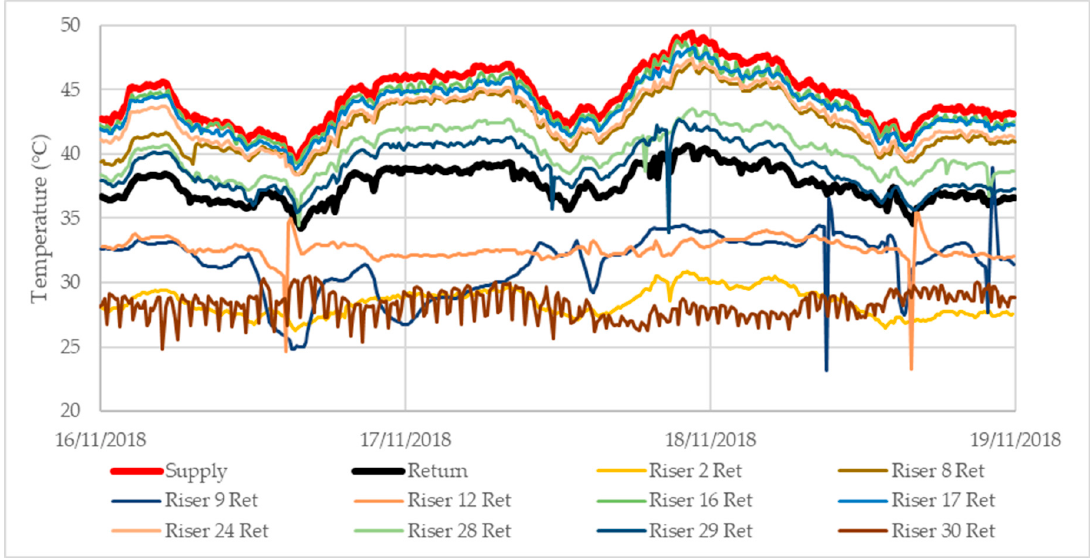
Figure 14. Recording of the radiator system supply and return temperatures and the return temperature from several risers during the period between 16 November 2018 and 19 November 2018, before the implementation of the two suggested strategies.